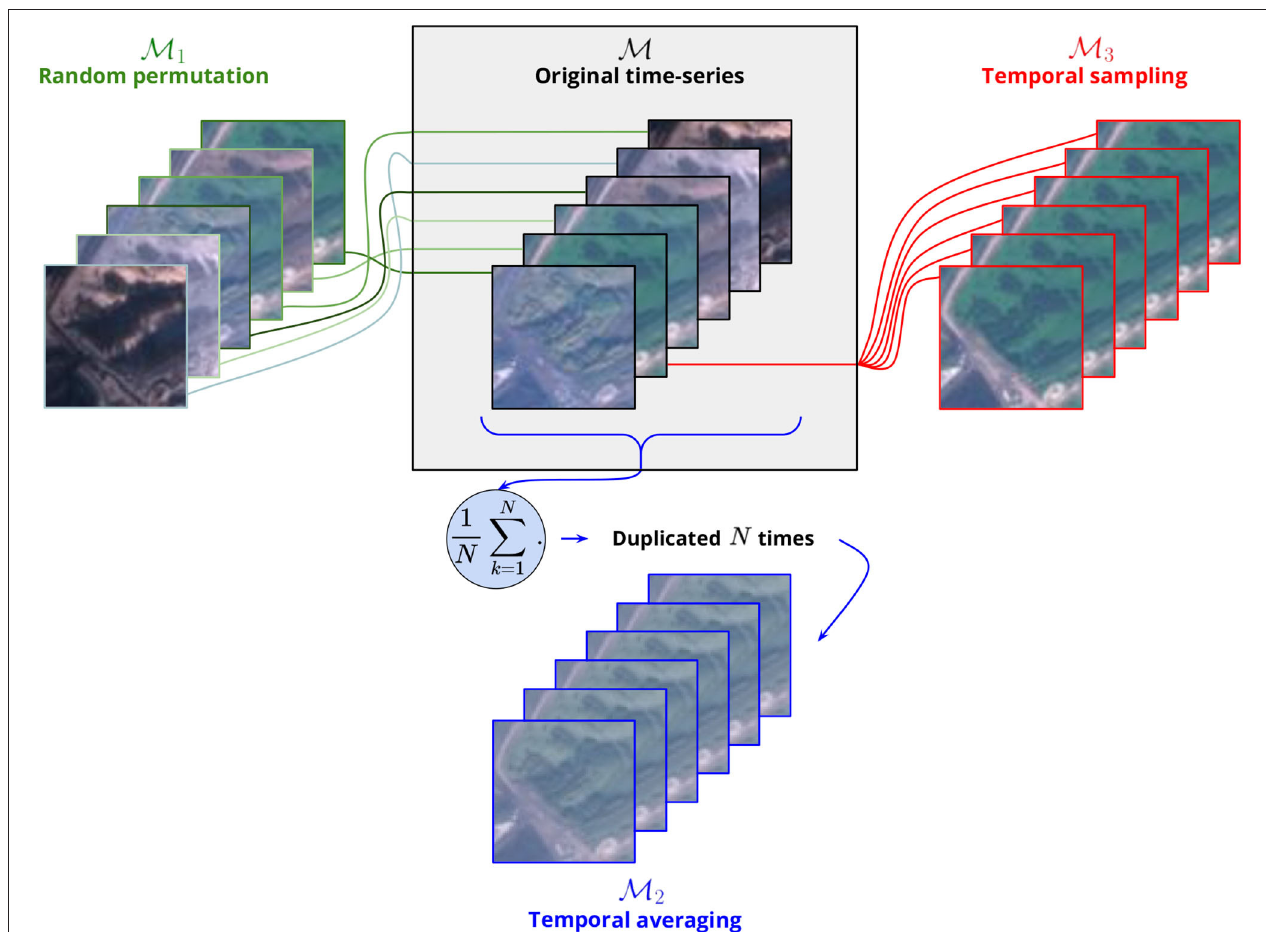
FIGURE 7 | Scheme illustrating the three transformations applied to the input image time-series toward interpreting the contribution of the temporal information. Only 6 RGB images are depicted but these procedures are applied on the whole 12-month-long time series, IR channel included (here N = 6 but would normally equal 12). The image time-series A (black legend) corresponds to the original data, i.e., to the images stacked in chronological order. The image series B 1 (green legend) is obtained by randomly permuting the original time series. The image series B 2 (red legend) is made of 1 month picked at random and replicated N times. The image series B 3 (blue legend) is constructed by averaging the 12 images of the original time series and replicating the resulting mean image N times. Please note that the same legend’s colors will be used in the figures of the paper presenting the results of these